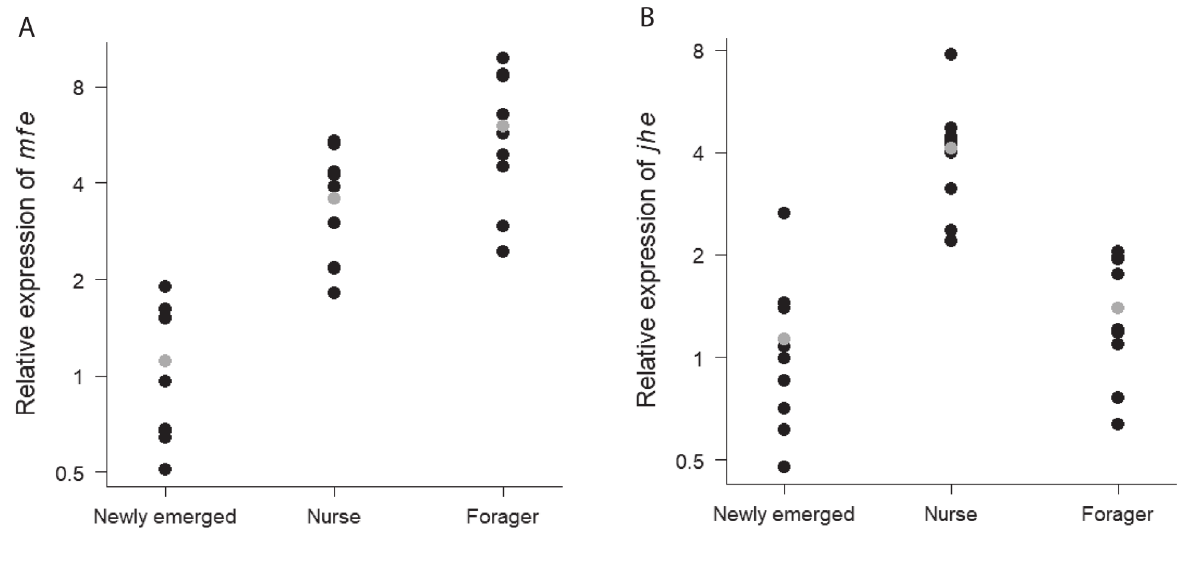
Figure 2 ‒ Relative expression levels of mfe ( A ) and jhe ( B ) in relation to age-related division of labor among workers of Melipona interrupta . Each point represents an individual (n = 27). The x-axis shows the groups of workers performing distinct activities. The y-axis shows the relative expression ratios (i.e., fold changes) of target genes in experimental samples relative to calibrator samples. The mean of Cq (quantification cycle) values obtained from the newly emerged workers was used as calibrator. Mean values of relative expression ratios are shown in gray. Expression of both mfe and jhe varied significantly among worker groups (ANOVA for mfe : F = 31.81, p = 1.8x10 -7 ; ANOVA for jhe : F = 23.3, p = 2.39x10 -6 ). ( A ) mfe expression increased significantly in nurses (Tukey test: diff = 1.74, p = 3x10 -5 ) and foragers (diff = 2.45, p = 2x10 -7 ) compared to newly emerged workers. However, there was no significant difference in mfe expression between nurse and forager stages (diff = 0.71, p = 0.08). ( B ) jhe expression increased significantly from newly emerged to nurse stage (Tukey test: diff = 1.95, p = 3x10 -6 ) and decreased significantly from nurse to forager stage (diff = 1.58, p = 7x10 -5 ). There was no significant difference in jhe expression between newly emerged and forager stage (diff = 0.37, p =